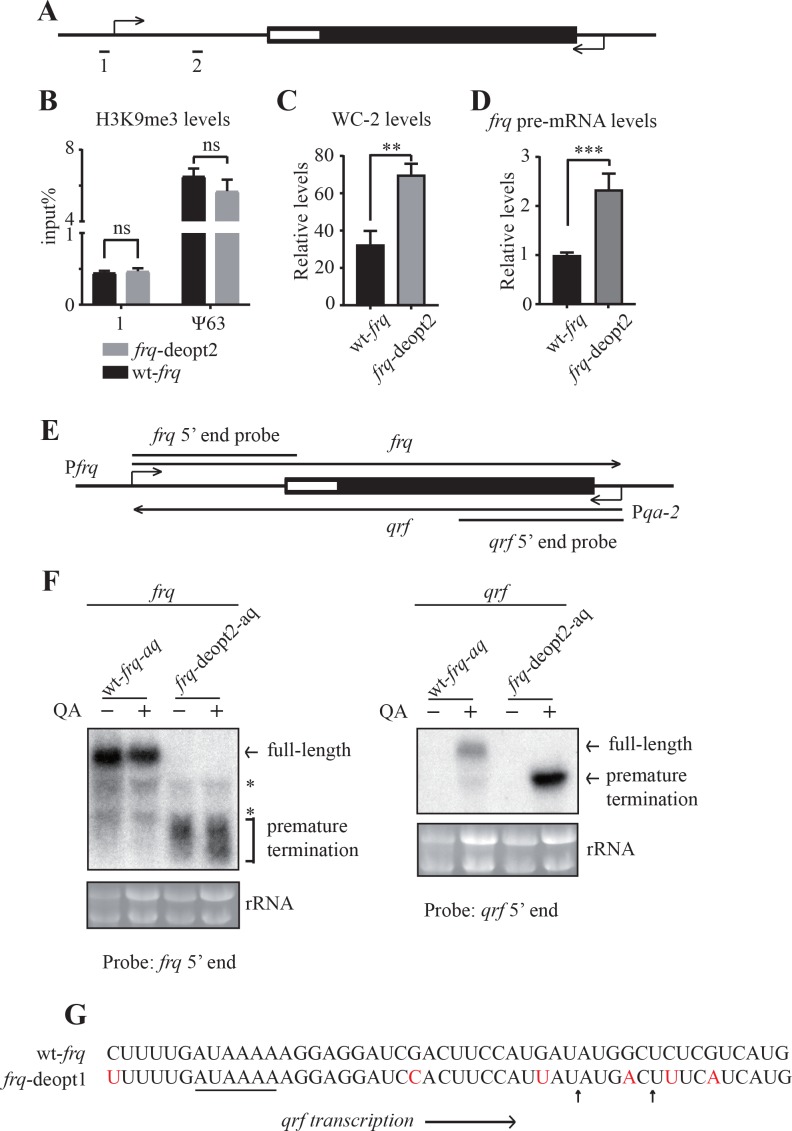
Mechanism of the codon usage-mediated gene expression changes at the frq locus(A) A diagram showing the frq locus. Primer set one is used to detect H3K9me3 levels (B) and WC-2 levels (C); primer set two is used to detect frq pre-mRNA levels (D). (B) ChIP analysis showing H3K9me3 levels at the frq promoter in the wt-frq and frq-deopt2 strains. The ChIP results were normalized by input DNA and represented as percentage of input (Input%). The heterochromatic region ψ63 was used as a positive control. ns, not significant. (C) ChIP assay showing WC-2 enrichment at the frq promoter in the wt-frq and frq-deopt2 strains. The ChIP results were first normalized by input DNA then normalized by an internal control β-tubulin and represented as relative levels. **p<0.01. (D) Strand-specific RT-qPCR assay showing frq pre-mRNA levels in the wt-frq and frq-deopt2 strains. ***p<0.001. (E) A diagram showing the frq locus. RNA probes used for detecting prematurely terminated frq mRNA and for detecting qrf in northern blot assay are indicated. The promoter of qrf was replaced by a qa-2 promoter, which is activated only in the presence of quinic acid (QA). (F) Northern analysis detecting frq (left) and qrf (right) in the wt-frq-aq and frq-deopt2-aq strains. The asterisks indicate non-specific bands. – means without QA in the medium, and +means with QA in the medium. (G) Poly(A) sites of prematurely terminated qrf mapped by 3’ RACE. Arrows indicate the mapped poly(A) sites, and the black line indicates a potential PAS motif (AAUAAA). Nucleotides that are mutated are shown in red.